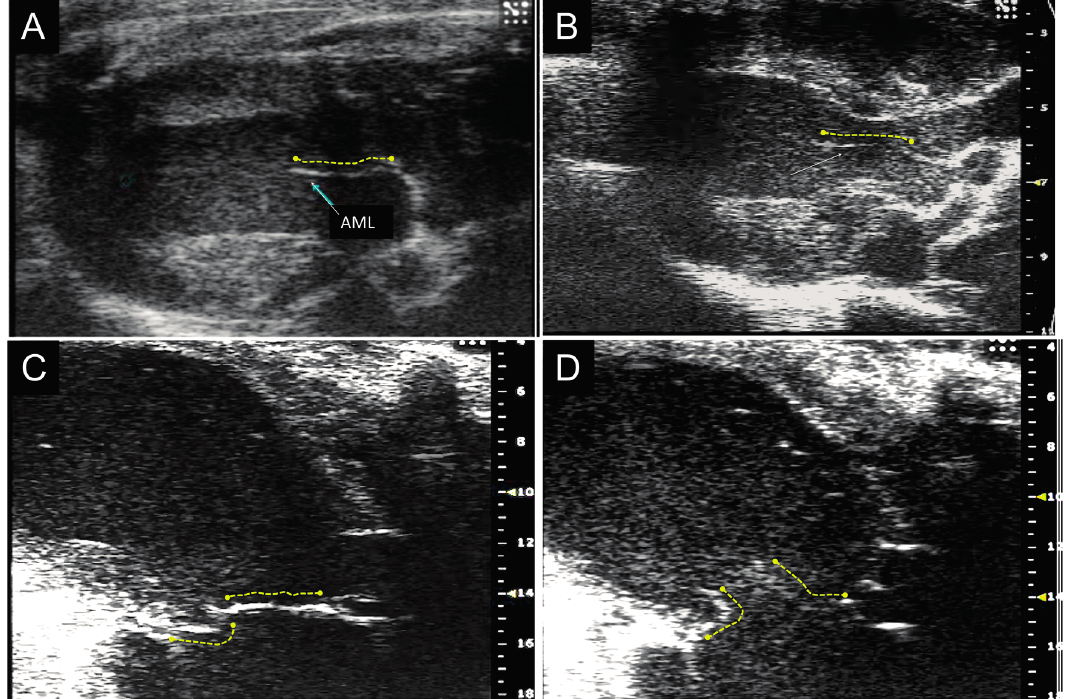
Figure 1. Imaging of the MV by high-resolution echocardiography. Representative echocardiographic images are shown from Mybpc3 ( − / − ) ( A , C , D ) and (+/+); ( B ) mice; arrows show AML; Systolic ( C ) and diastolic ( D ) images are shown with AML and PML